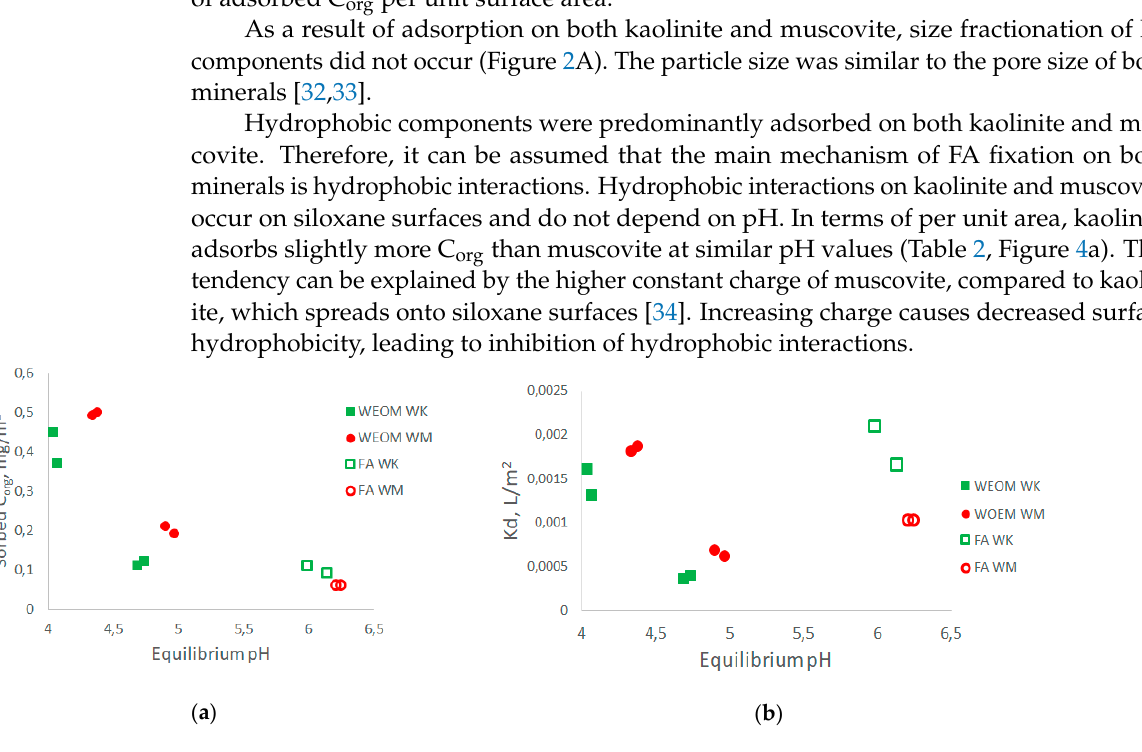
Figure 4. The dependence of adsorbed C org ( a ) and Kd ( b ) on equilibrium pH. According to the data of potentiometric kaolinite titration, pH PZC is approximately 7 (Table 1), which greatly exceeds the range of pH PZC of kaolinite from 2.7 to ≈ 5.7 [14,24,35]. Kriaa et al. [36] report higher pH PZC from 6.5 to 7.8 units for kaolinite from the deposits of amount of muscovite, which is likely to increase the pH PZC